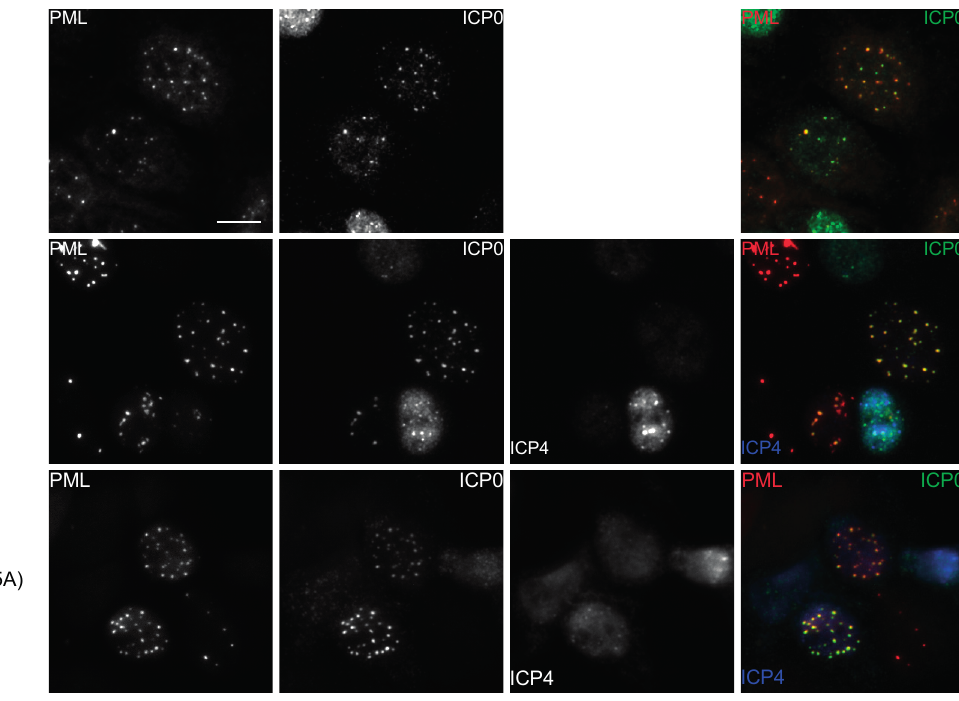
and ICP0 during HSV-1 infection. HA-shPML cells transduced with FLAG-, CFP-tagged PML-I or each PML-I mutant were infected with HSV-1 at 2 PFU/cell. At 2 hpi, the cells were fixed and stained with antibodies against ICP0 and ICP4. PML is shown as red, ICP0 as green, and ICP4 as blue in the merged image. Scale bar = 10 μ